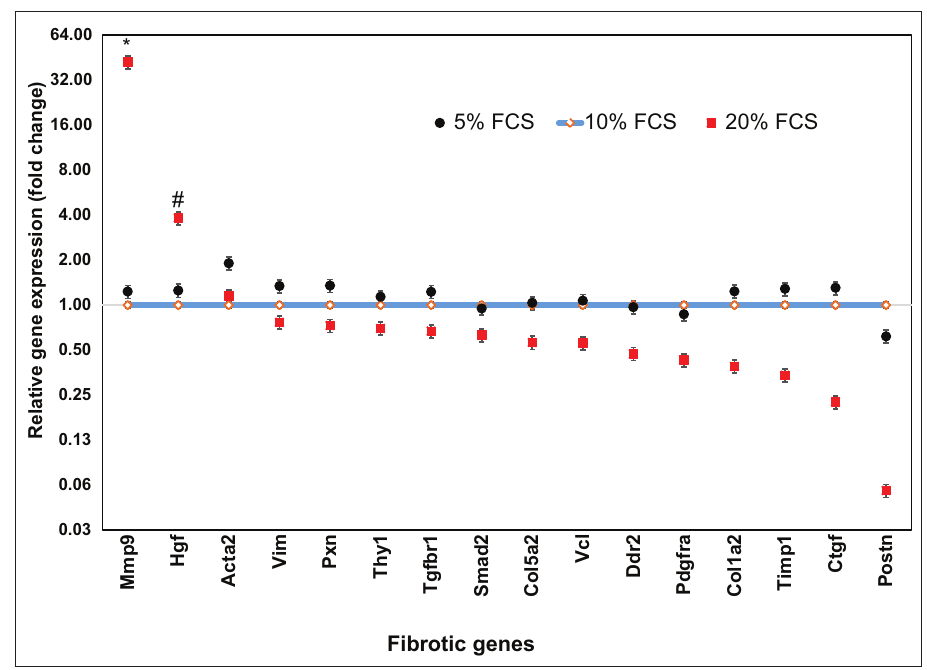
Figure-6: Effects of serum concentration on fibrotic gene expression. Gene expression of 10% fetal bovine serum culture (conventional culture) was set to 1 and the gene expression of culture in 5% and 20% serum was calculated relative to conventional culture. Increasing serum concentration to 20% resulted in a reduction of most fibrotic gene expression, except for matrix metallopeptidase 9 and hepatocyte growth factor, which was significantly increased (*p<0.01, # p<0.05). Cell culture was done in six replications, while quantitative polymerase chain reaction was done in three replications.